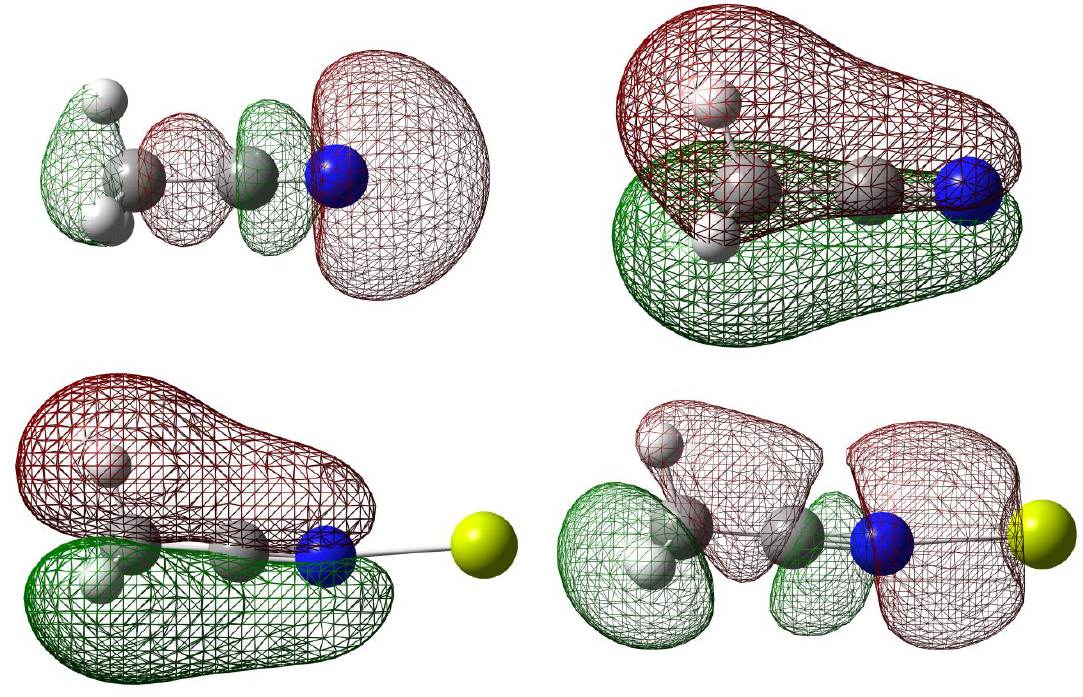
CN; ( ii ) HOMO-3 of CH 3 CN-Mg(II). 3